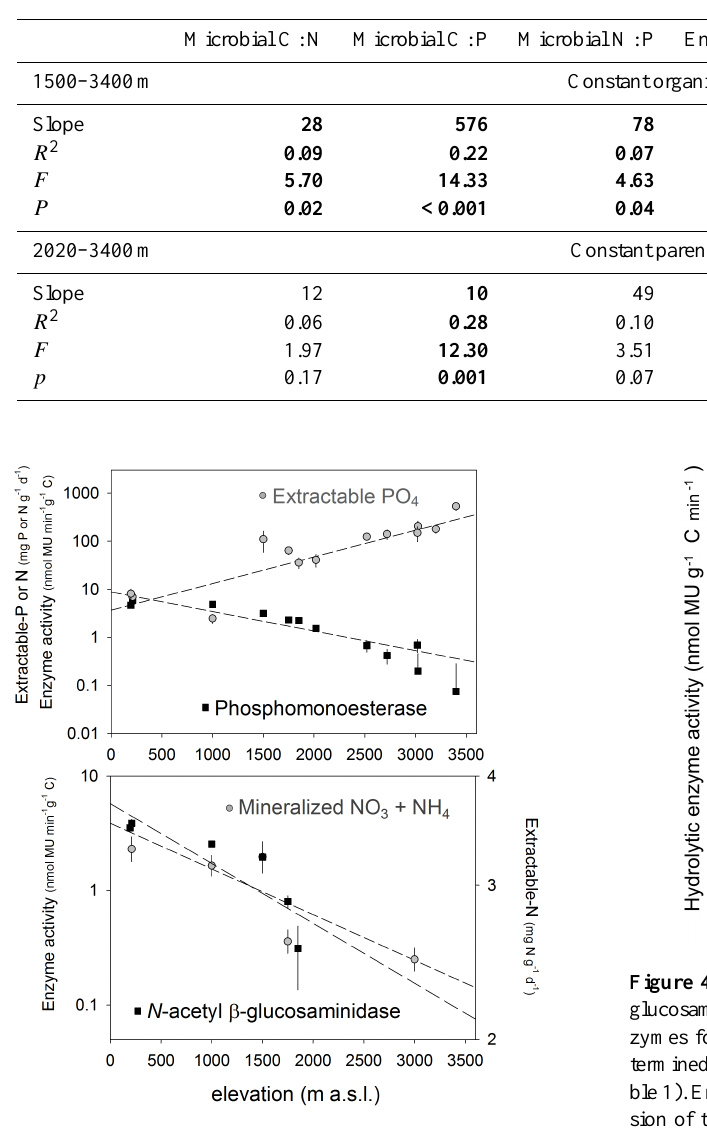
Figure 3. The decline in phosphomonoesterase activity and increase in resin-extractable P with elevation; and the decline in N -acetyl β - glucosaminidase activity and decline in total mineralized N (NO 3 + NH 4 ) with elevation. Linear regressions are shown, where p <0.05. Spearman correlation coefficients are reported in Table 4. Values are means ± 1 SE ( n = 5).